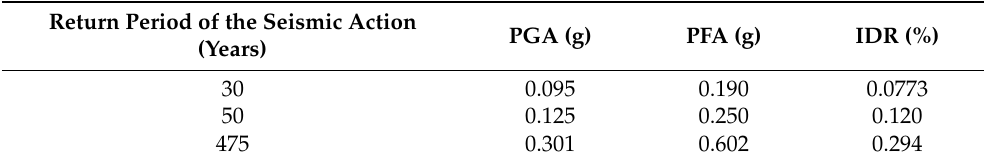
Table 13. PGA, PFA, and IDR values considered for the second example of the application of the proposed seismic classification